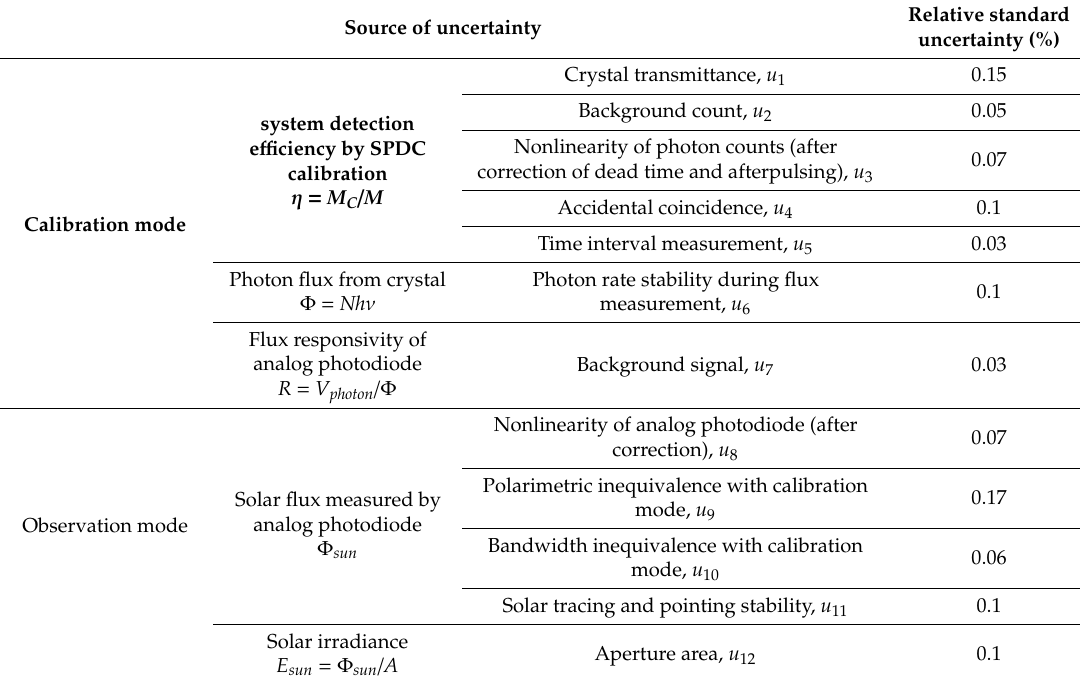
Table 1. Estimated uncertainty budget for solar irradiance